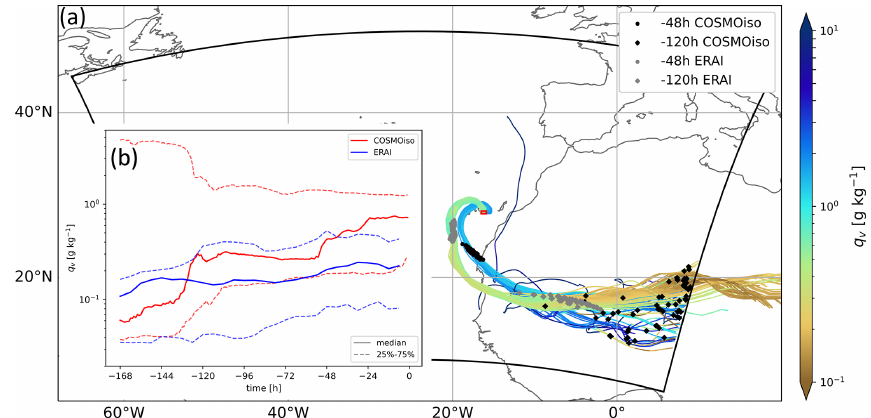
Figure A1. (a) COSMO iso and ERA-Interim backward trajectories started every hour between 10:00–13:00UTC on 30 July 2013 (corre- sponding to the observation period of airborne in situ measurements) from the 500hPa level in the area of the MUSICA aircraft campaign (small red box). The trajectories are coloured according to their specific humidity q v . The skewed black box depicts the COSMO iso model domain in rotated coordinates. Dots and diamonds show the COSMO iso (black) and ERA-Interim (grey) trajectory positions 2 and 5d be- fore arrival. (b) Temporal evolution of q v along the COSMO iso and ERA-Interim backward trajectories displayed in (a) . The red and blue solid lines represent the median of the 90 COSMO iso and ERA-Interim trajectories and the red and blue dashed lines the corresponding interquartile